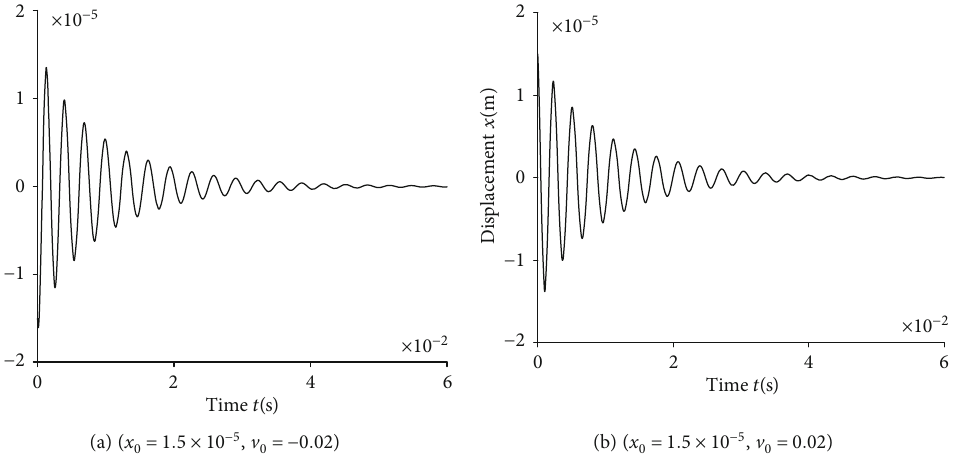
= 1 : 0 A , q = 1 × 10 − 4 m 3 /s . 0 0